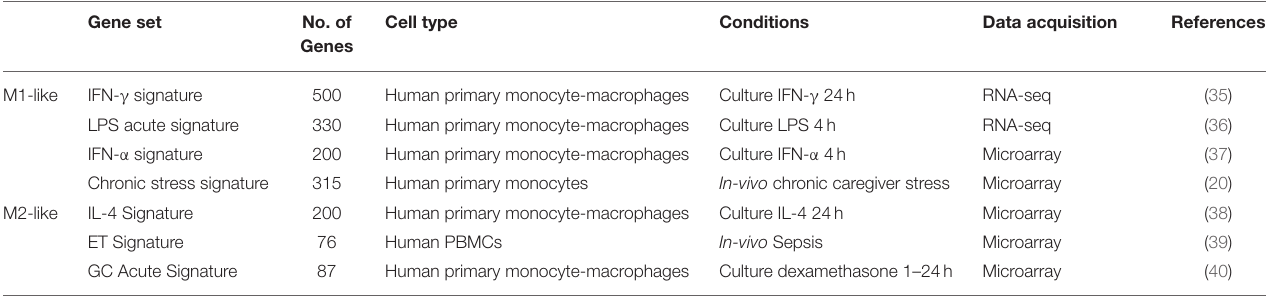
TABLE 2 | Gene set s, i.e., transcriptional signatures, representative of specific “M1-like” and “M2-like” monocyte phenotypes compiled from the published literature that were used for GSEA. Gene